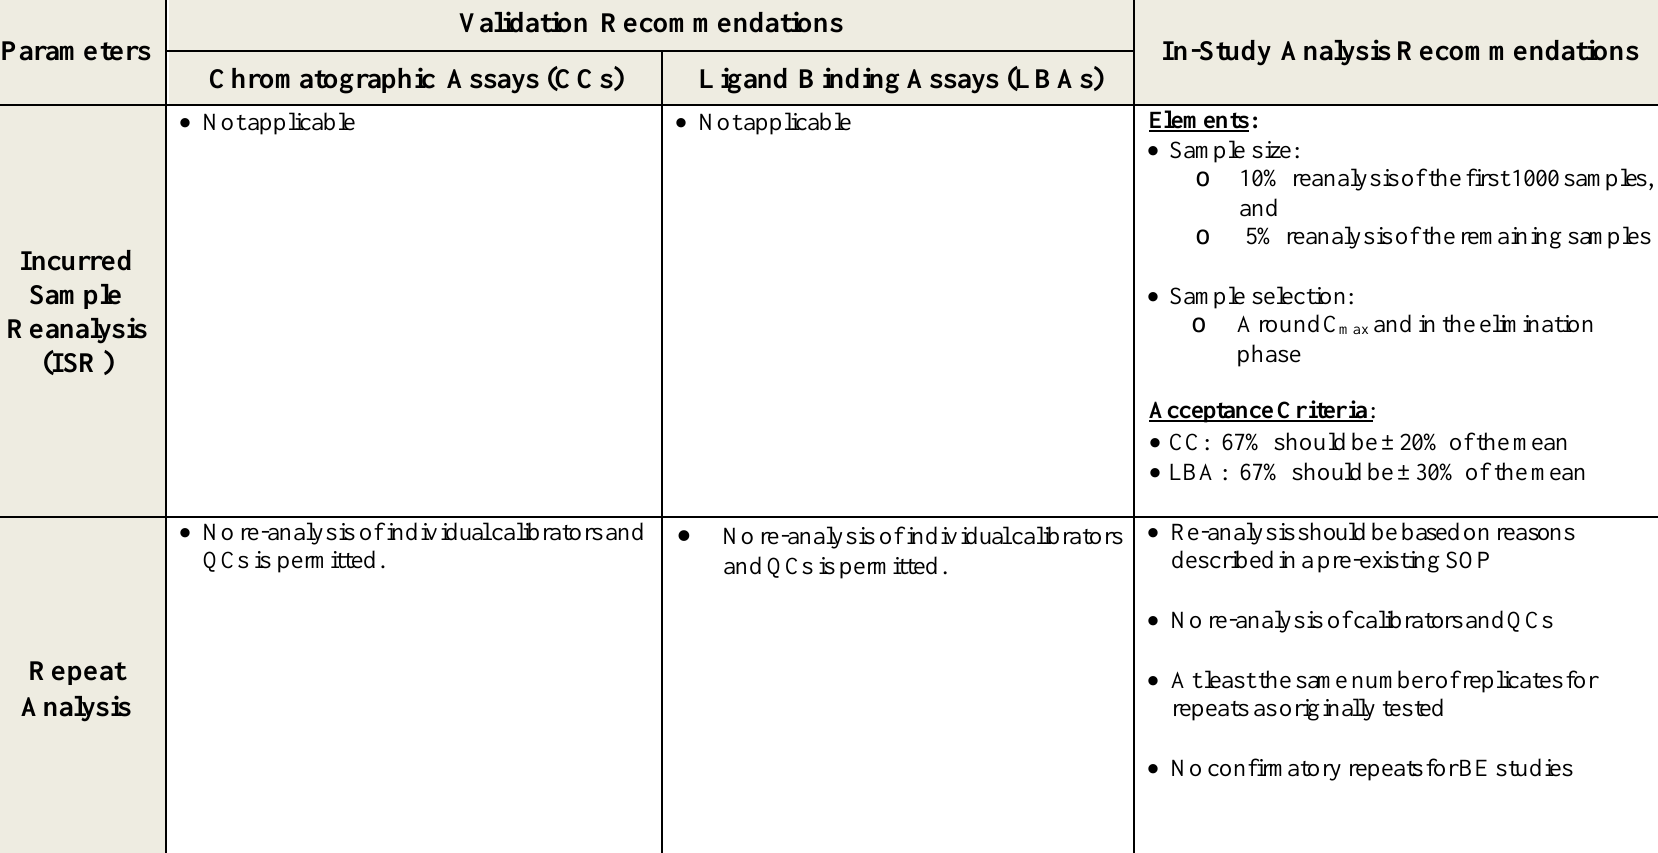
Table 1 continued. Recommendations and Acceptance Criteria for Bioanalytical Method Validation and In-Study